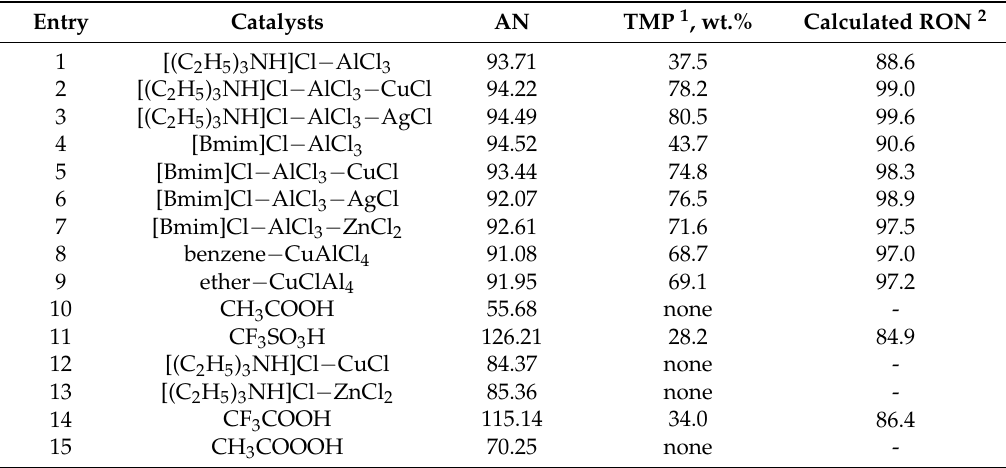
Table 2. The relationship between Acceptor Number (AN) value and the alkylate selectivity.